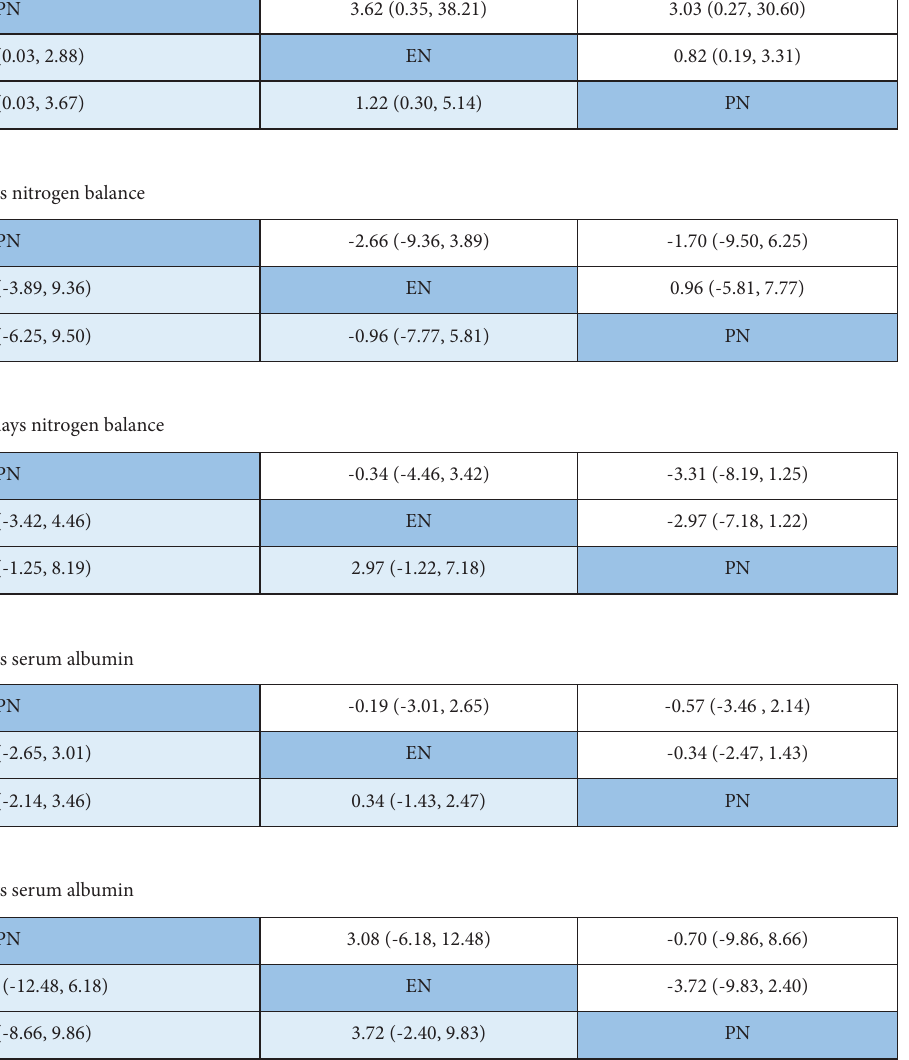
Figure 6: Te matrix for the results of the in-hospital mortality, 5–7days nitrogen balance, 11–14days nitrogen balance, 0-1days serum albumin, and 5–7days serum